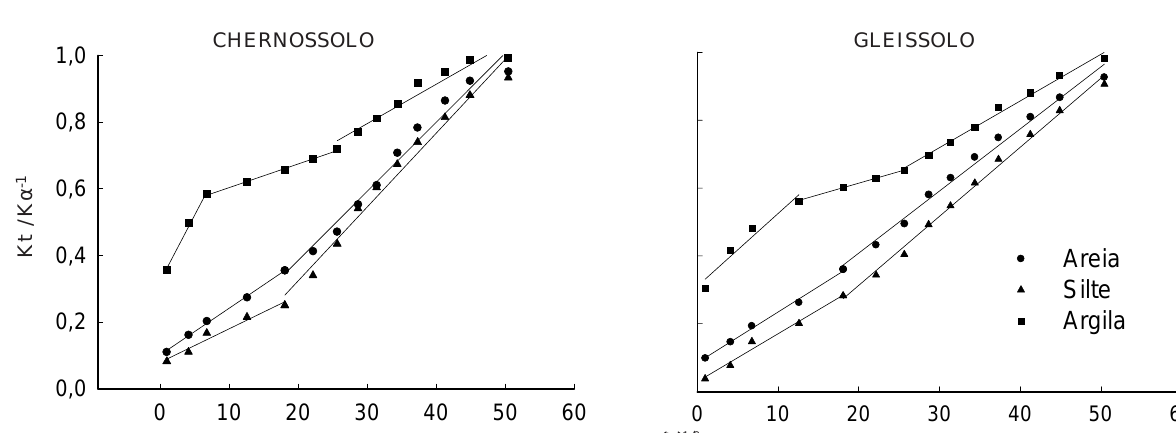
Figura 2. Cinética da liberação de potássio das frações granulométricas do Chernossolo e do Gleissolo descrita pela equação parabólica de